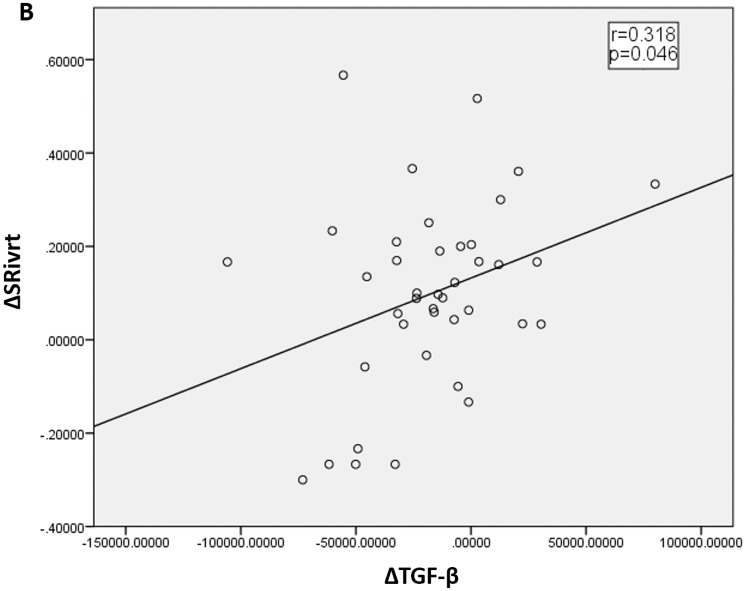
Relationship between TGF-beta levels and strain rate indices. The post-operational changes in TGF-beta levels correlated with the post-operational changes in global strain rate during the isovolumetric relaxation period (SRIVR), which is a sensitive marker of cardiac diastolic function. r, correlation coefficient; P, significance level.